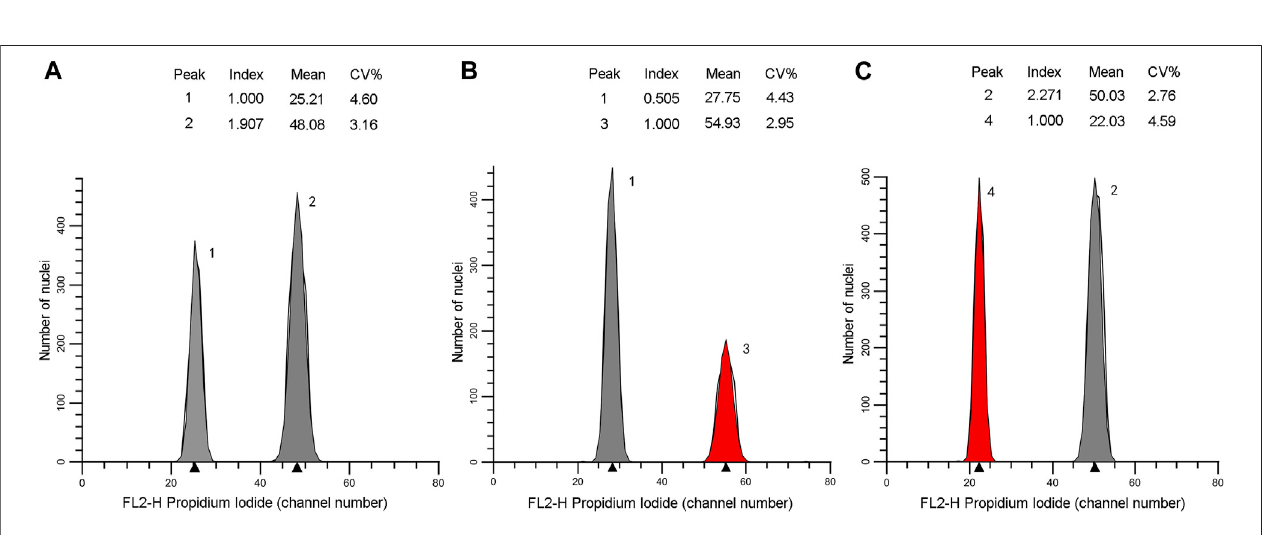
Frontiers in Genetics |